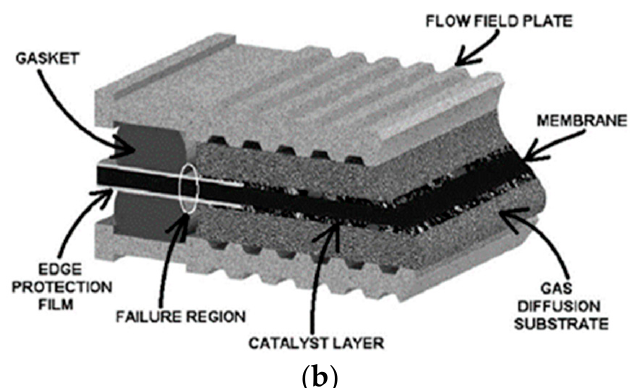
Figure 6. Mechanical damage may occur at the edge of the membrane electrode, leading to early failure. ( a ) Model-predicted distribution of maximum principal tensile strain in the MEA as a result of RH variation from 75 to 0% [47]. ( b ) Schematic diagram of the fuel cell structure, including the location of the protective membrane [49].